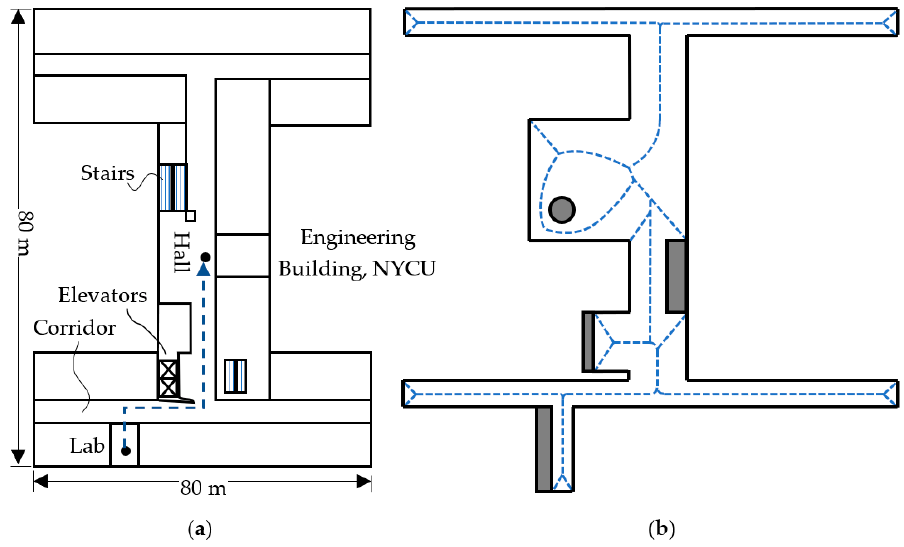
Figure 2. ( a ) Computed Voronoi segments of the floor map and ( b ) path search along the Voronoi edges.